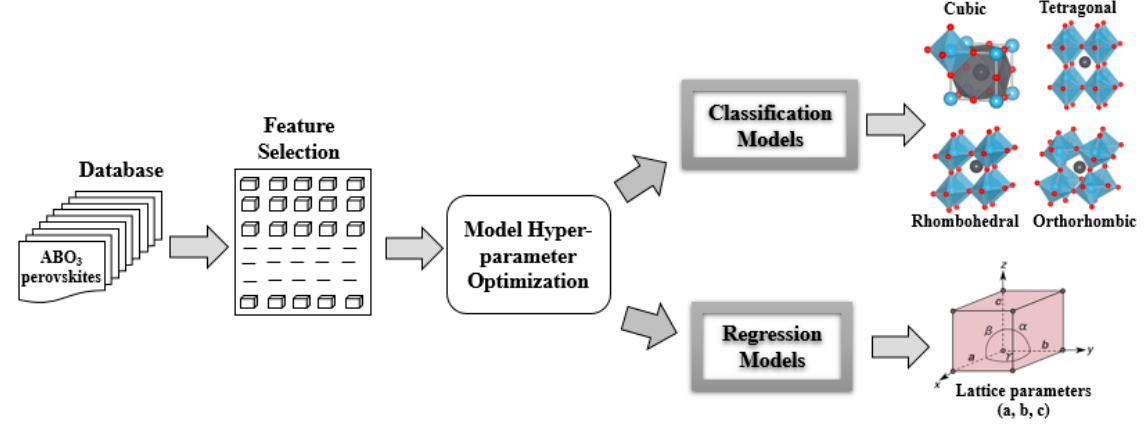
Figure 2. Workflow demonstration of the whole project.